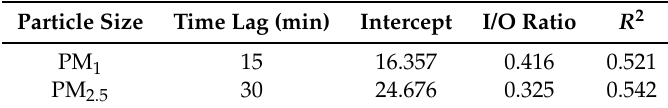
Table 4. Estimated I/O ratio using linear regression.